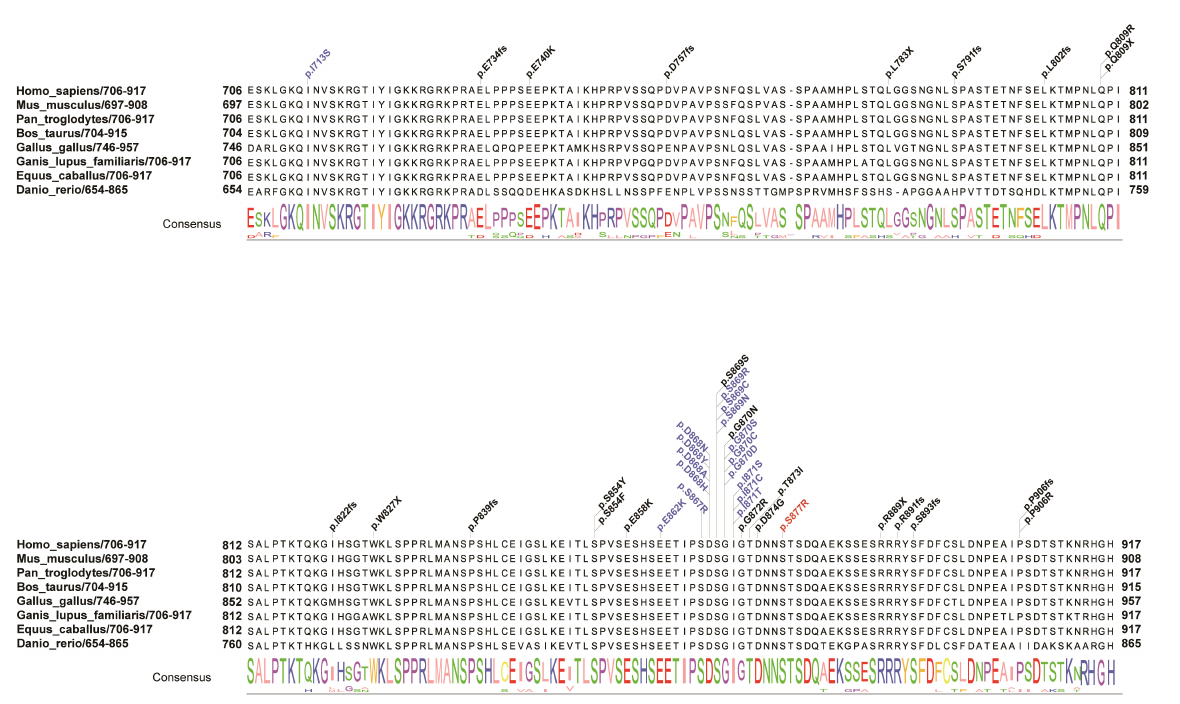
FIGURE2 Schematic presentation of the linear SETBP1 protein of the SKI domain with all pathogenic variants. Red indicates the reported variant in the present study that caused an amino acid change (p. S877R) in a highly conserved region. Blue and black indicate variants found in SGS patients and other intellectual disability patients from public data and the literature. The consensus sequence shows the conserved score for each amino acid across eight species. Different colors of the consensus sequence represent different amino acids, and the larger the character, the more conserved the amino acid